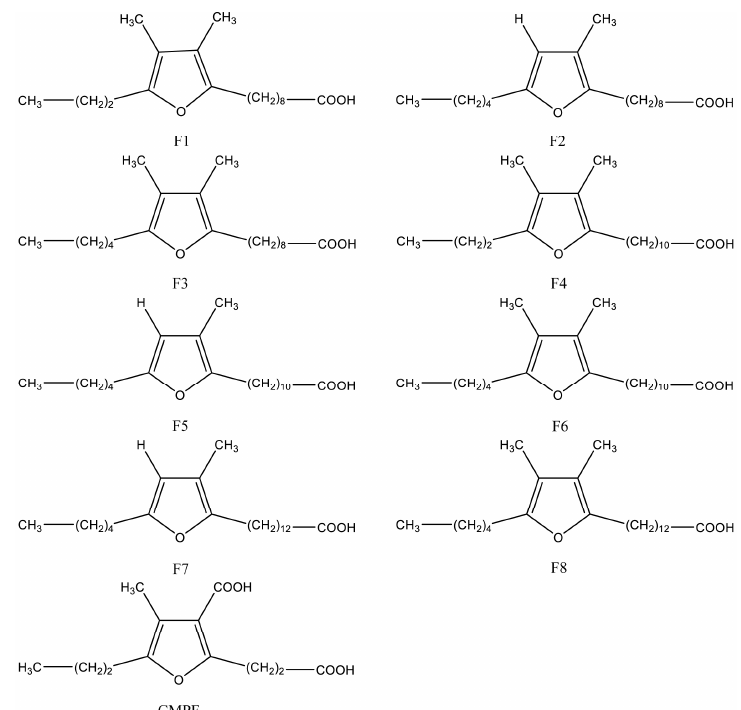
Figure 1. Structure of most abundant furan fatty acids (F1–F8) [35] and their bioactive metabolite 3-